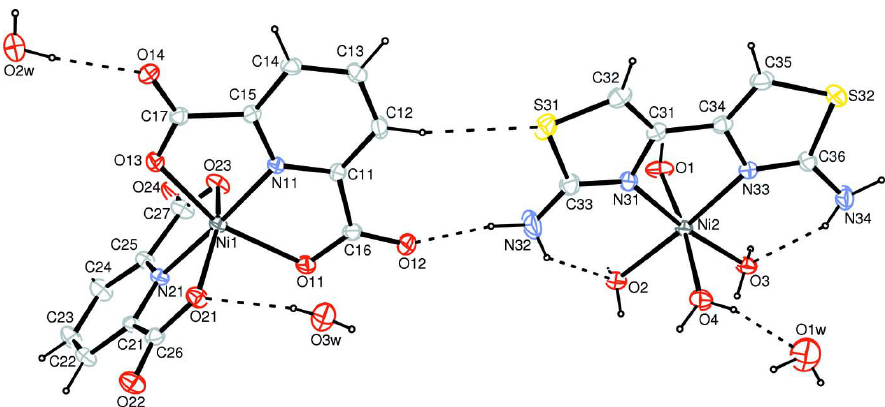
Figure 1 The molecular structure of (I) with 30% probability displacement ellipsoids (arbitrary spheres for H atoms), dashed lines showing the hydrogen